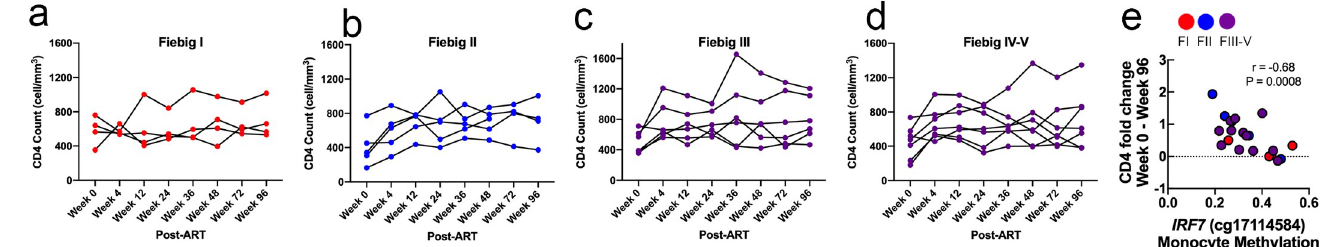
Fig 8. DNA methylation related to the IRF7 gene in monocytes relates to CD4 fold change at 96 weeks following the initiation of ART during acute HIV infection. (a-d) Line plots of longitudinal CD4 count in participants by Fiebig stage from week 0 (pre-ART) through post-ART time points out to week 96. (e) Correlation plot displaying relationship between IRF7 DNA methylation levels in monocyte cells assessed at baseline and CD4 fold change calculated from week 0 to week 96. Fiebig stage of participant displayed: Fiebig I displayed in red, Fiebig II displayed in blue, and Fiebig III-V displayed in purple.